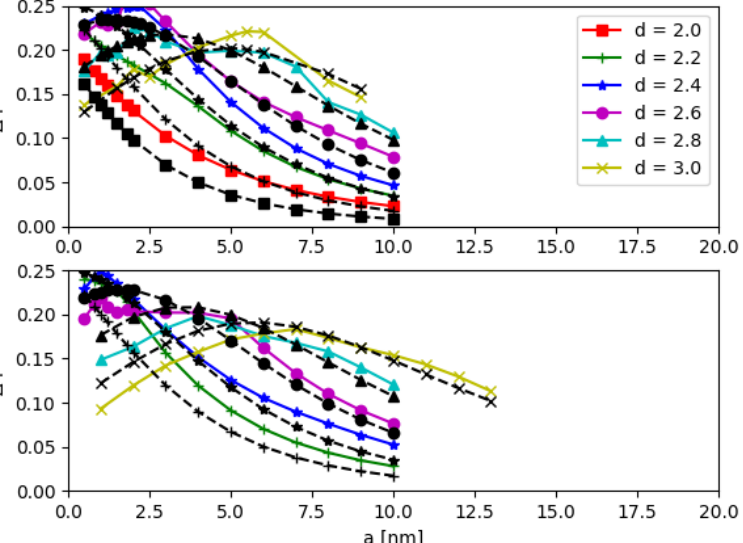
Figure 11. CNOT operation efficiency ∆ P as a function of the inter-DQD distance a , the QD base length b = 1.6 nm and b = 1.8 nm for the top and bottom panels, respectively. The different inter-QD distance d is depicted by different symbols. The black dash lines and other color solid lines are from the matrix and electronic potential models, respectively.